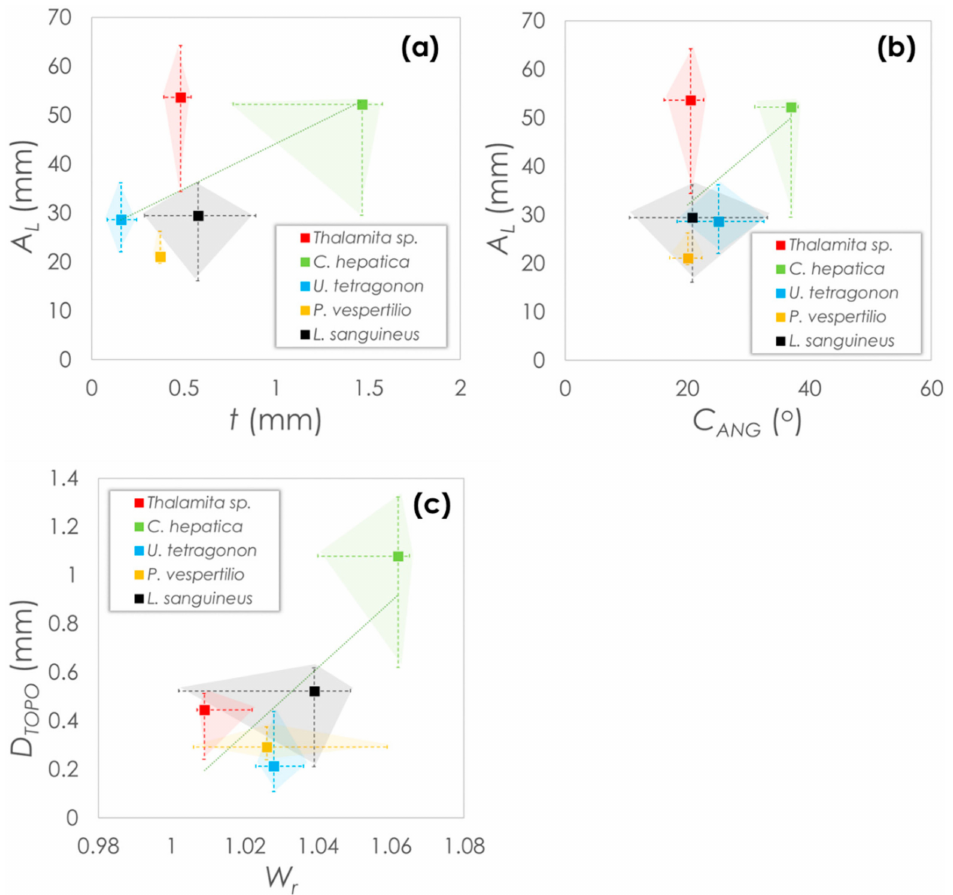
Figure 7. Morphological comparisons between crab species: ( a ) carapace arc length and carapace thickness, ( b ) carapace arc length and carapace angle; ( c ) topographical depth and 2D Wenzel